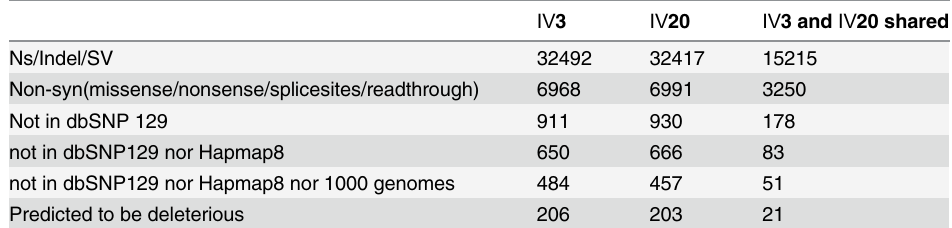
PLOS ONE | DOI:10.1371/journal.pone.0136245 August 21,